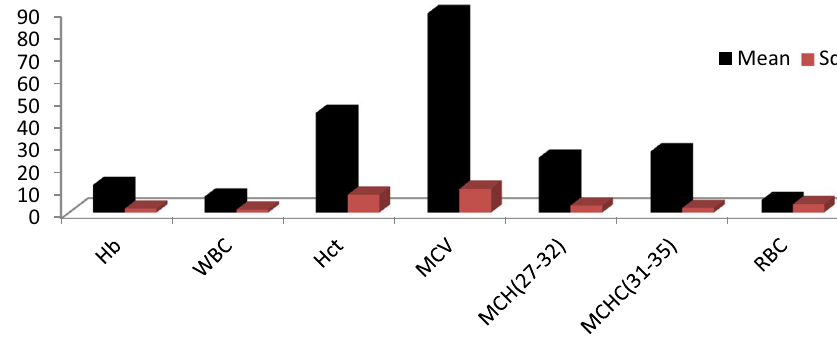
as Ca 2+ (mg/L), 11. magnesium as Mg 2+ (mg/L), 12. potassium as K + (mg/L), 13. sodium as Na + (mg/L), 14. chloride as Cl − (mg/L), 15. sulfate as SO 42− (mg/L), 16. conductivity at 25 °C (μS/cm), 17. nitrate as NO 3− (mg/L), 18. nitrite as NO 2− (mg/L), 19. fluoride F − (mg/L), 20. arsenic (μg/L)